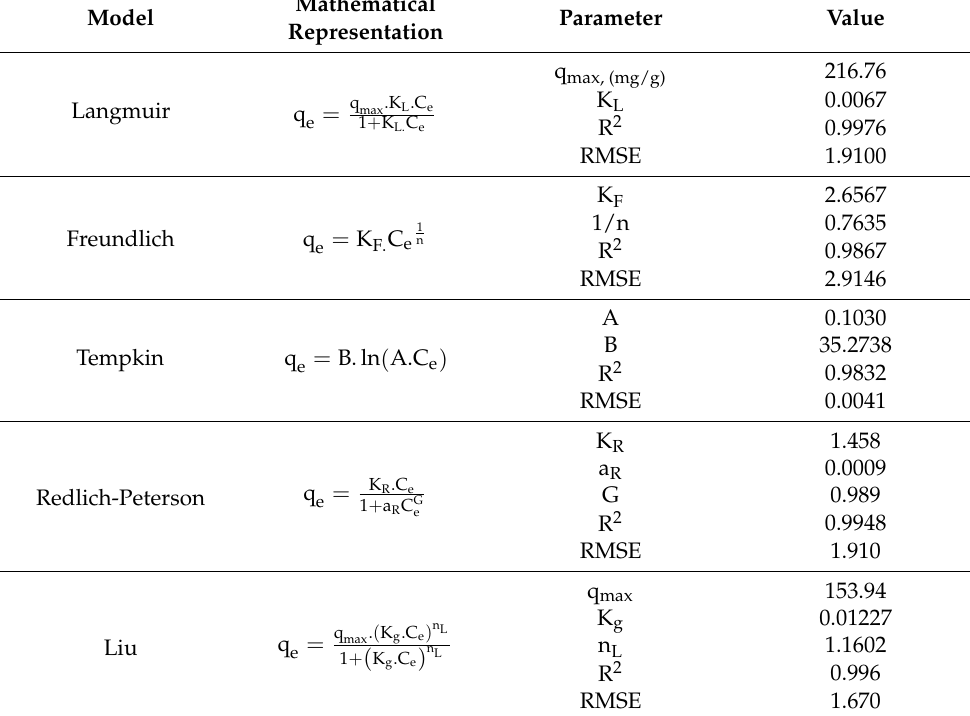
Figure 6. Plots for experimental data vs. predictions for non-linear equilibrium models for SBAC- MgAlFe phenol uptake. Table 5. Parameters for different non-linear equilibrium models under the optimal